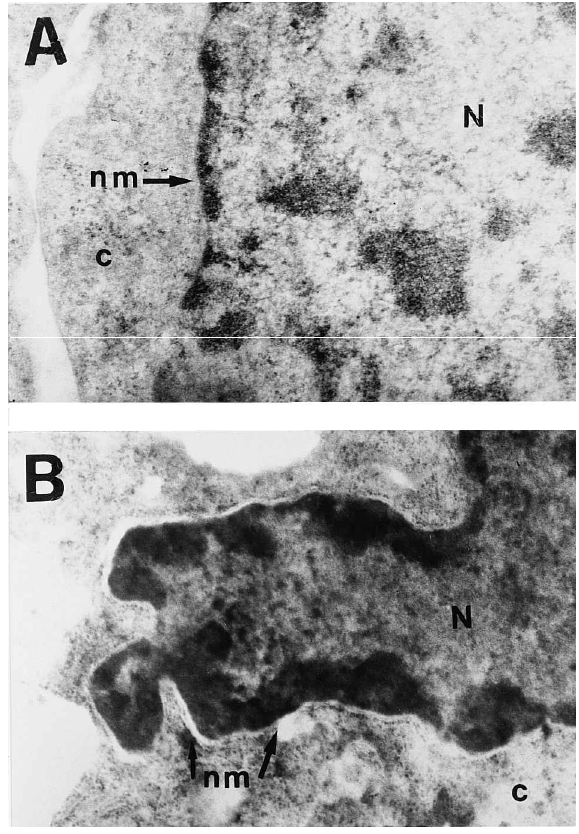
FIG. 4. Transmission electron microscopy of RIN-5AH cells treated with: (A) IL-1 a +AG where no condensed chromatin is obtained; 3 20000; (B) IL-1 b +AG with condensed nuclear chromatin; 3 13000 (N, nucleus; nm, nuclear membrane; c,